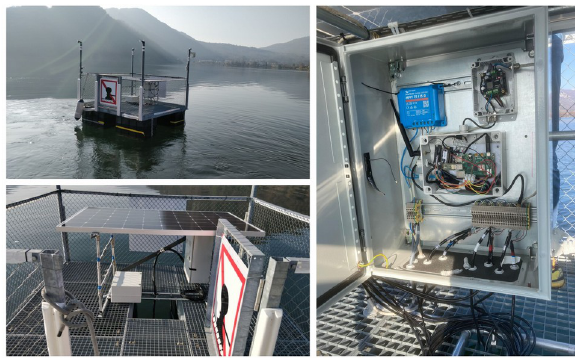
Figure 1 . Open Lake monitoring system, sensor domain composed by mooring platform, power components (solar panel and backup battery) and control unit (processor and